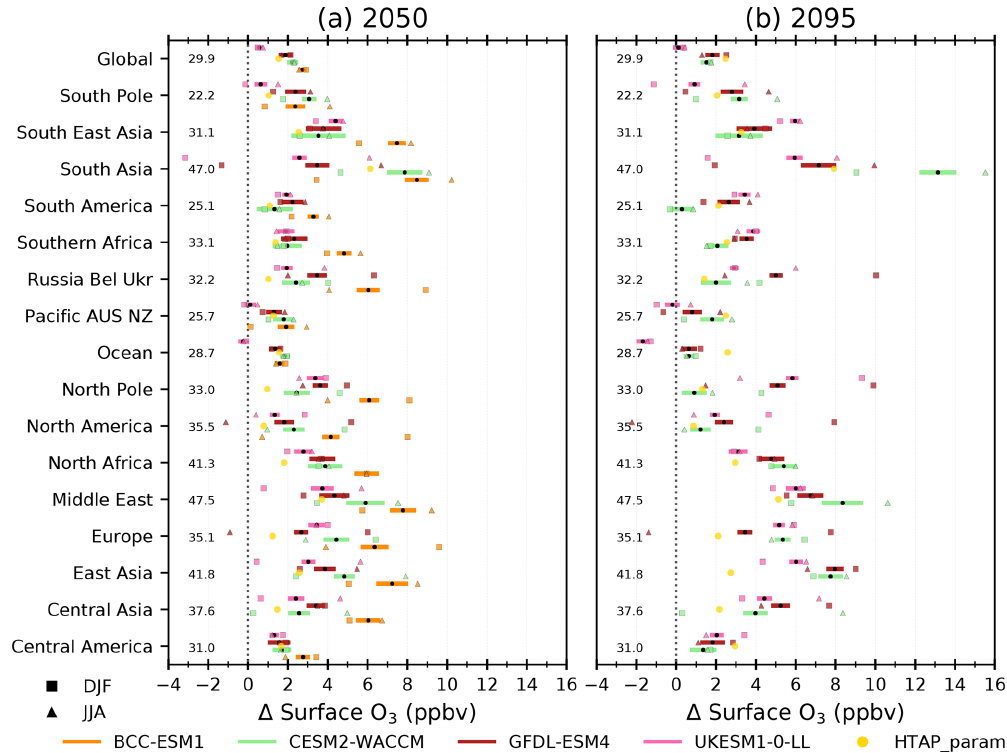
Figure 12. Future global and regional changes in the annual and seasonal mean surface O 3 , relative to the 2005–2014 mean, for the ssp370 pathway used in CMIP6. Each black circle represents the annual mean response for an individual model in (a) 2045–2055 and (b) 2090– 2100, with the coloured bars showing the SD across the annual mean. The DJF and JJA seasonal mean response averaged over the relevant 10-year period is shown by squares and triangles, respectively. The multi-model regional mean over the period 2005–2014 is given towards the left of each panel. The response from the HTAP_param in each time period is shown by the separate gold